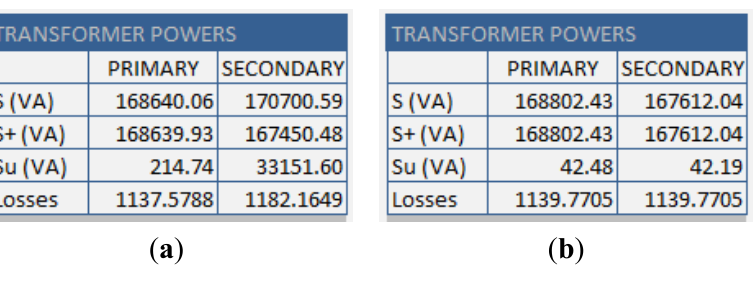
Figure 11. 4WD transformer voltages and currents after compensating and distributing the loads: ( a ) secondary side; ( b ) primary side.